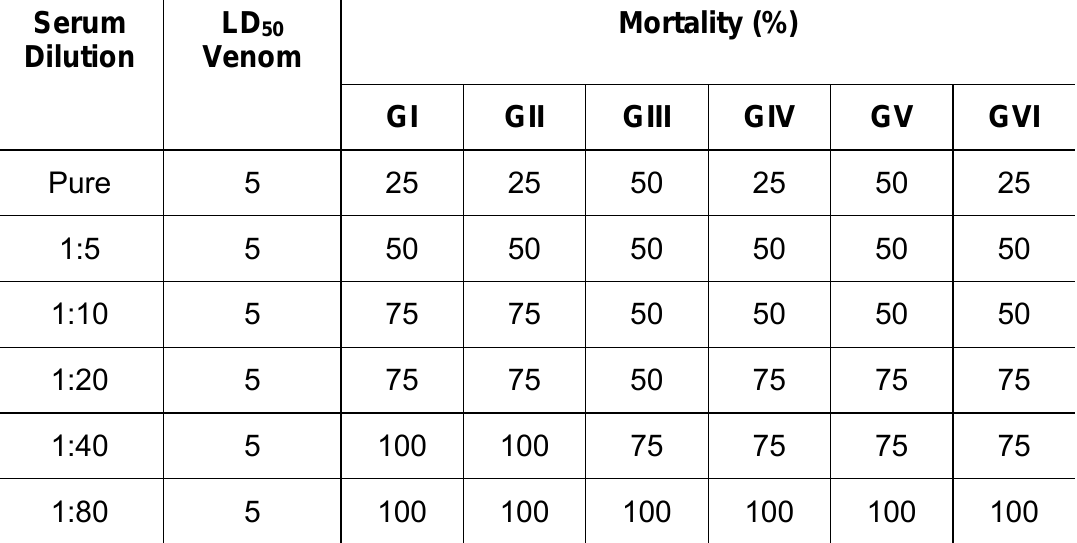
Table 2: Serum dilution for determination of the neutralizing capacity of Bothrops jararaca , native (GI) and irradiated (GII) , Bothrops jararacussu , native (GIII) and irradiated (GIV), and Bothrops moojeni , native (GV) and irradiated (GVI) antivenoms prepared with native or irradiated